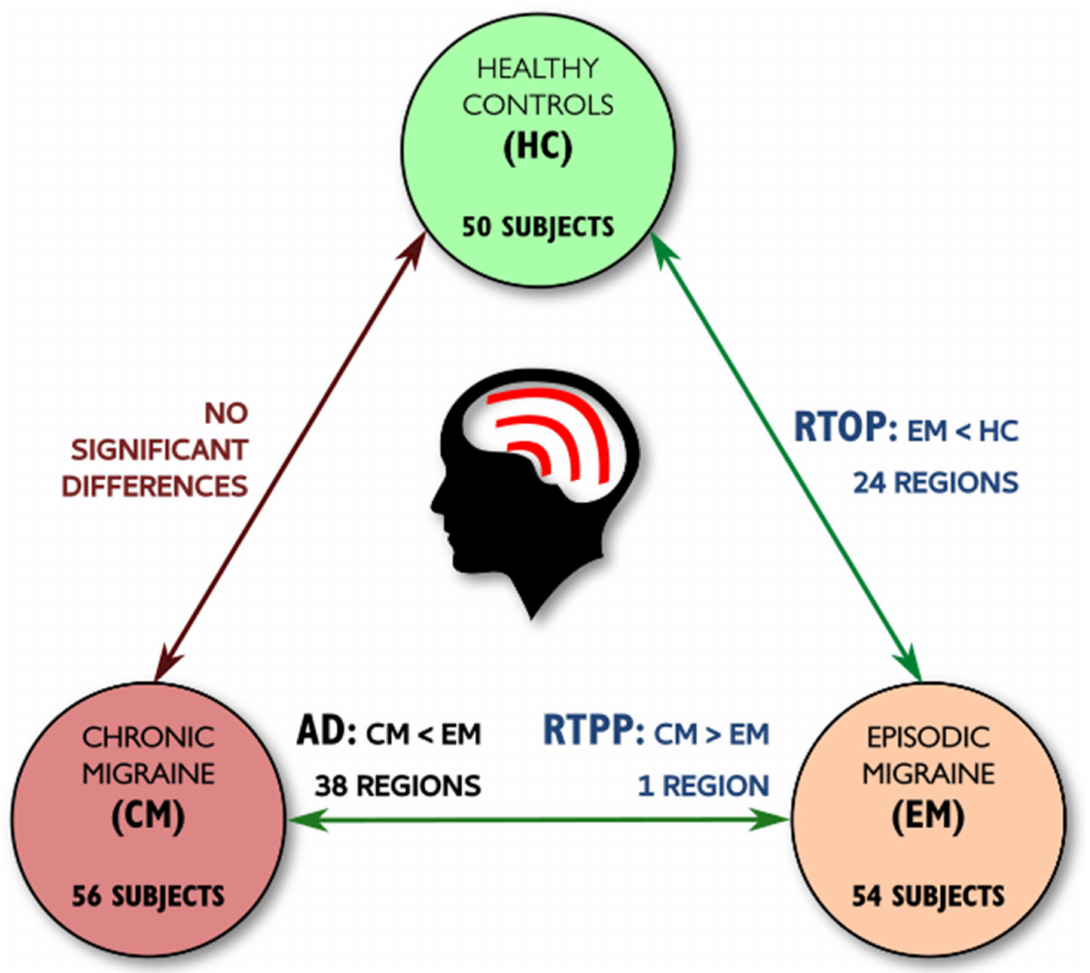
Figure 5. Summary of the main tract-based spatial statistics (TBSS) results with DTI and AMURA measures. Significant di ff erences between any migraine group and controls were found only with the RTOP from AMURA, identifying white matter alterations non-measurable with DTI. Di ff erences between CM and EM were found with RTPP from AMURA, and AD from DTI. No di ff erences were found between CM and